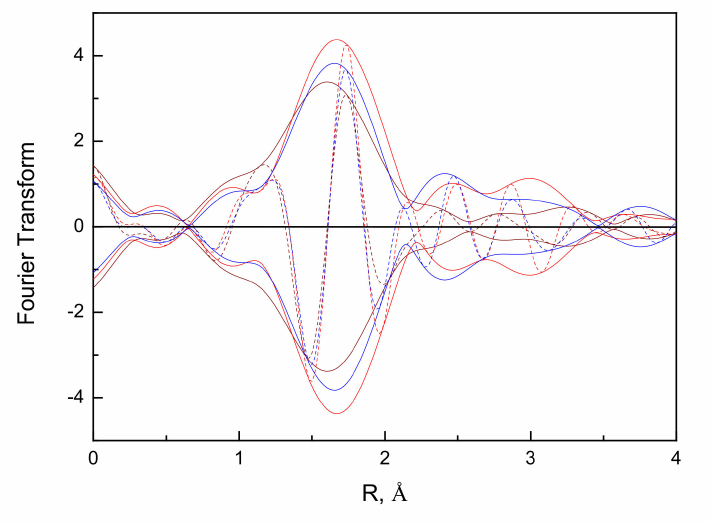
Figure 8. Fourier transform (3.5 < k 3 < 10.0, V-O phase corrected) of EXAFS spectra for V f (black), V r400 (blue), and V r450 (red); magnitude (solid line), imaginary (dashed